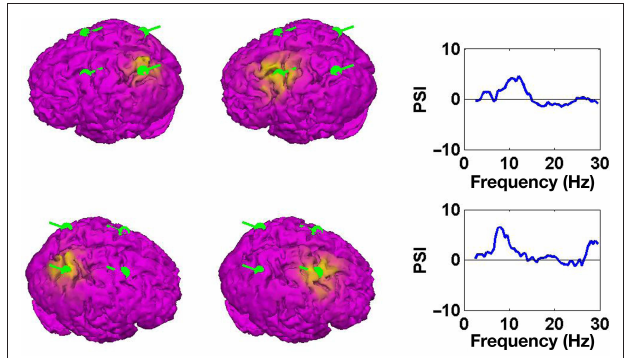
FIGurE 5 | Left and middle panels: estimated sources of the PISA components. Right panels: causal structure as function of function. Positive results indicate that the sources shown in the left panels drive those shown in the middle